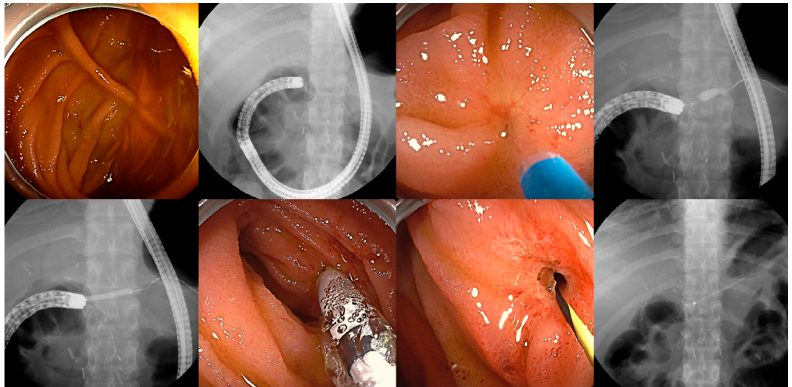
Figure 2. The procedure of endoscopic retrograde cholangiopancreatography using a cap-assisted colonoscope in a patient with pancreaticojejunostomy (PJ) stricture after pylorus-preserving pancre- atoduodenectomy with Roux-en-Y reconstruction and side-to-side jejunojejunostomy. After reaching the end of the afferent loop, the small hole indicating the PJ site was found. Balloon dilatation of the PJ stricture was performed. Subsequently, a plastic stent was placed in the main pancreatic duct for the prevention of recurrence of